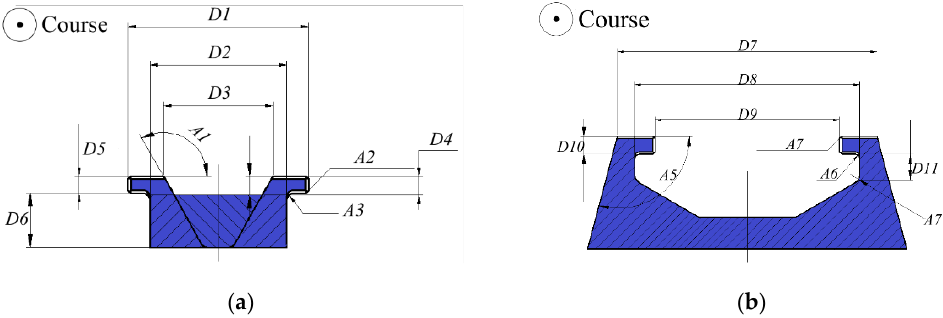
Figure 2. Structural diagram of the hanging mechanism. ( a ) “T”-shaped structure, ( b ) “U”-shaped structure.